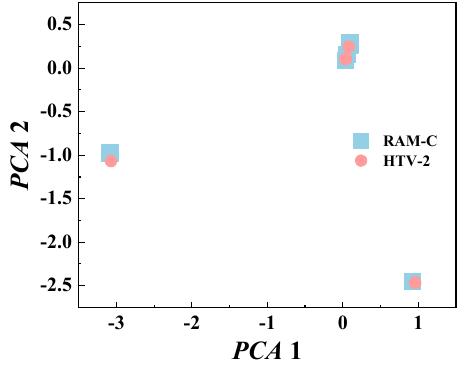
Figure 4. The HFs of RAM-C II and HTV-2 at typical flight states. ( a ) The flight states are 40 km 15 Mach, 40 km 20 Mach and 40 km 25 Mach. ( b ) The flight states are 50 km 15 Mach, 50 km 20 Mach and 50 km 25 Mach.